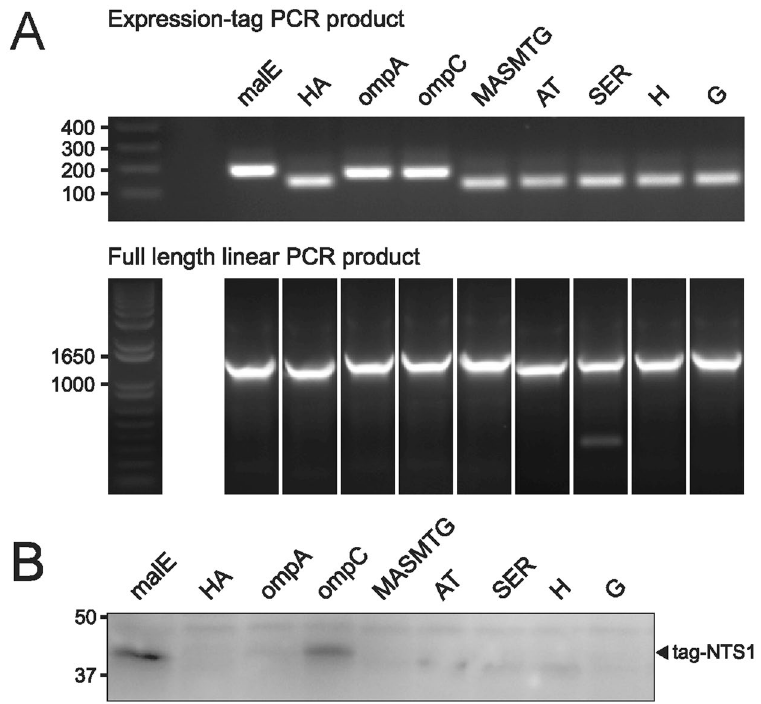
Figure 1. Overlap PCR of linear PCR expression templates and analytical scale CFPS test expression. ( A ) The various expression tags, containing all necessary regulatory elements were generated by an initial PCR. The expression tag, along with the PCR product of en2NTS 1 was used to generate the full-length PCR product with the all necessary regulatory elements required for in vitro expression. ( B ) Expression was assessed by immunoblot against the His-tag found at the C-terminus of en2NTS 1 . The malE-signal sequence was identified as the best candidate for expression by